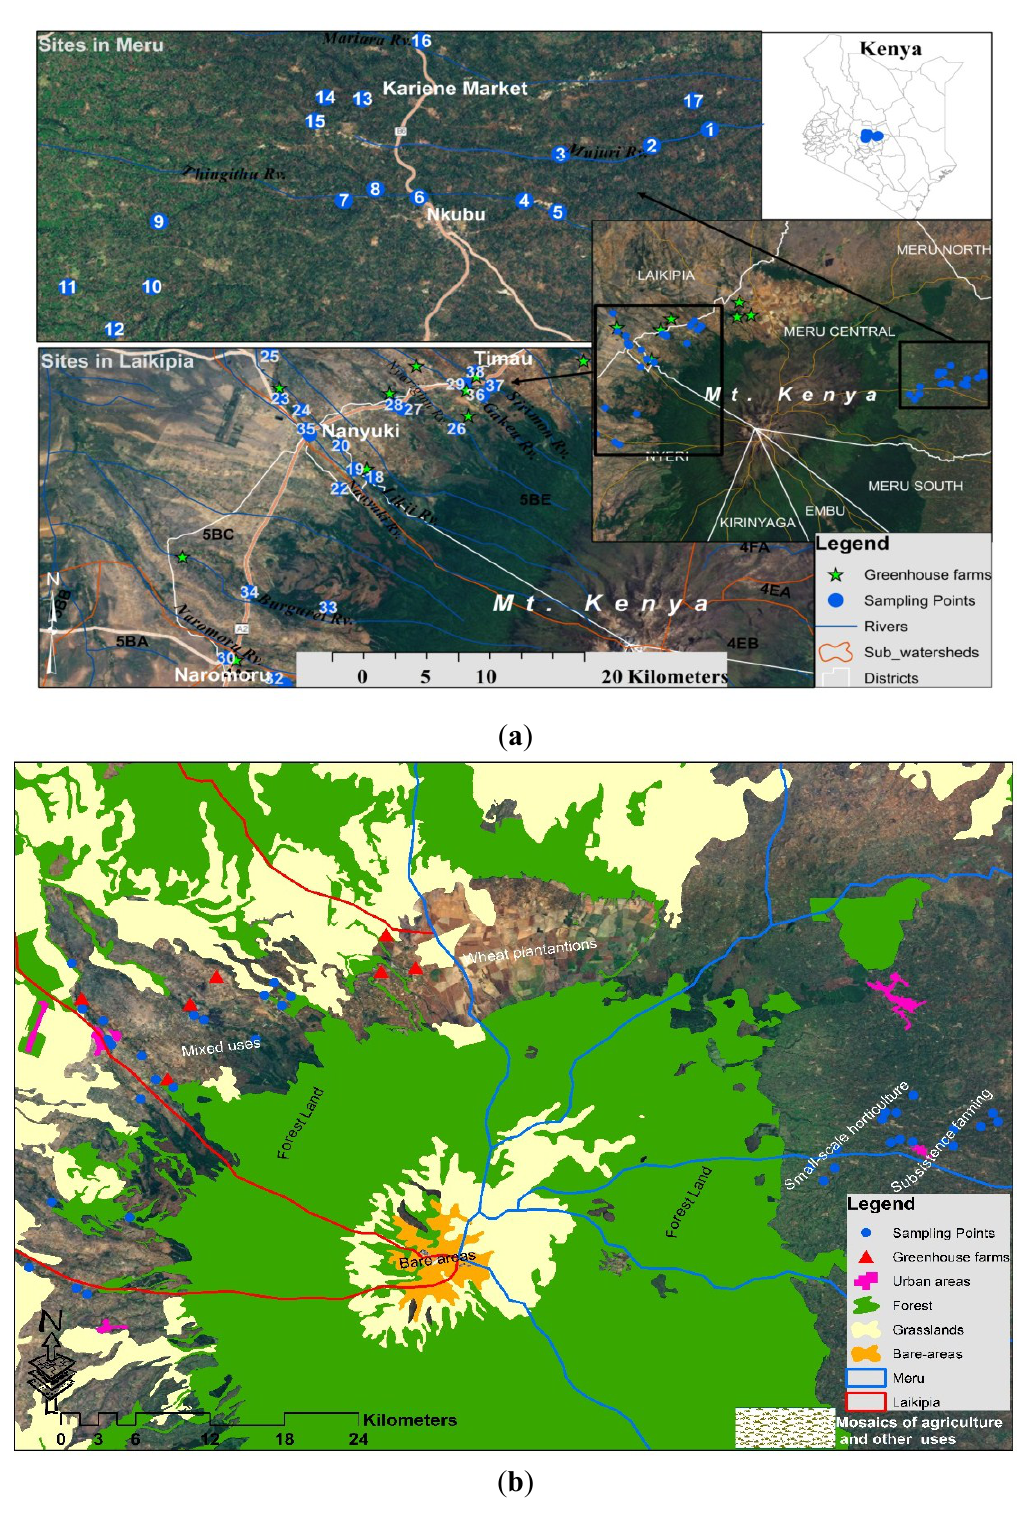
Figure 1. Study area maps. ( a ) Shows sub-watersheds around Mount Kenya, the surface water sampling points, and towns. To the West is Laikipia, which represents a growing cluster of large-scale commercial horticulture; and to the East is Meru, consisting of a mix of subsistence farming and intensive small-scale contracted horticulture farmers. ( b ) Shows various land cover and land uses within the study area (data source—World Resources Institute (WRI)